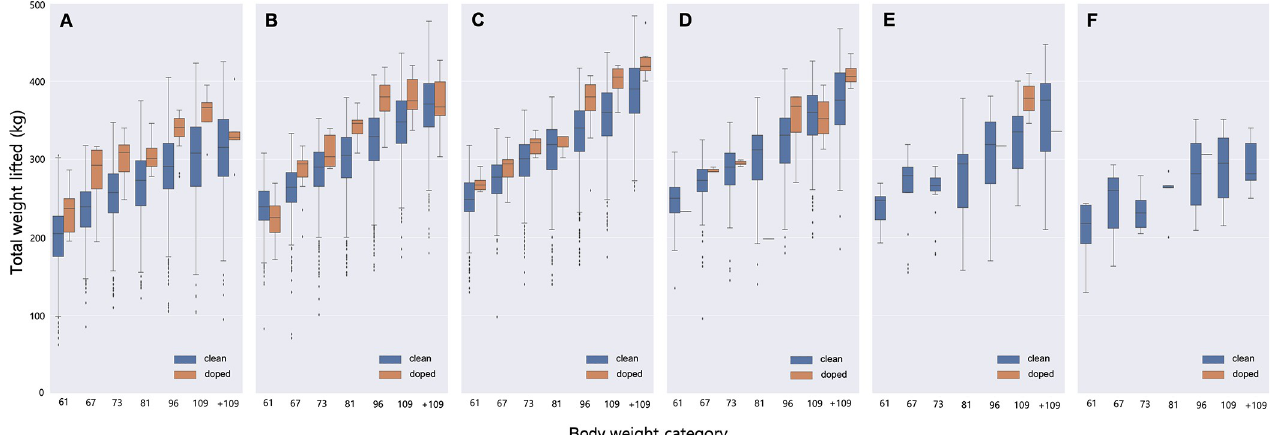
Fig 4. Male weightlifters’ performance in total weight lifted (kg) for each body weight category in the ages of 15–19 (A), 20–24 (B), 25–29 (C), 30–34 (D), 35– 39 (E), and 40–44 (F) (26,740 results of not-sanctioned, 289 results of sanctioned). Box plots of the average performance and outliers of each body weight category are grouped by sanction status (not-sanctioned or sanctioned) for comparison. Boxes indicate the 25 th and 75 th percentiles. Whiskers indicate 10 th and 90 th percentiles, with the middle horizontal line representing the mean. Dots indicate the outliers.